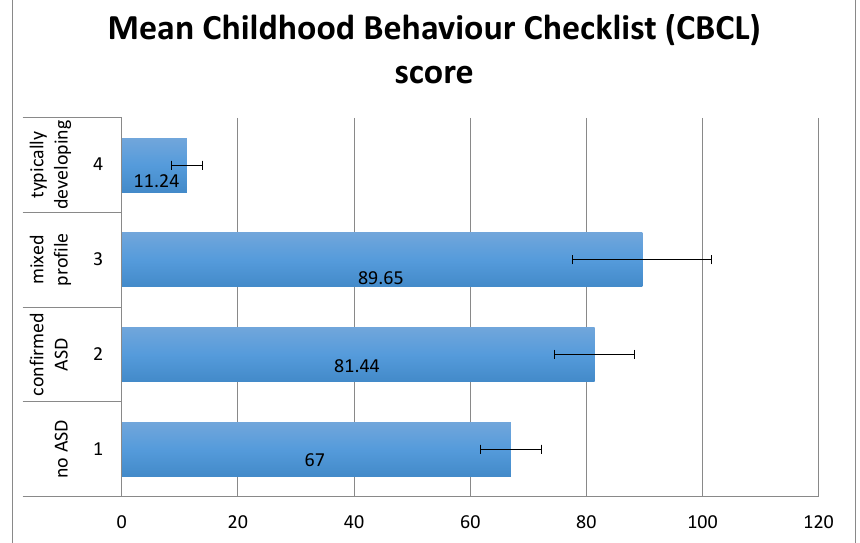
Figure 4. Mean CBCL scores by group. Error bars show ±1 standard error.